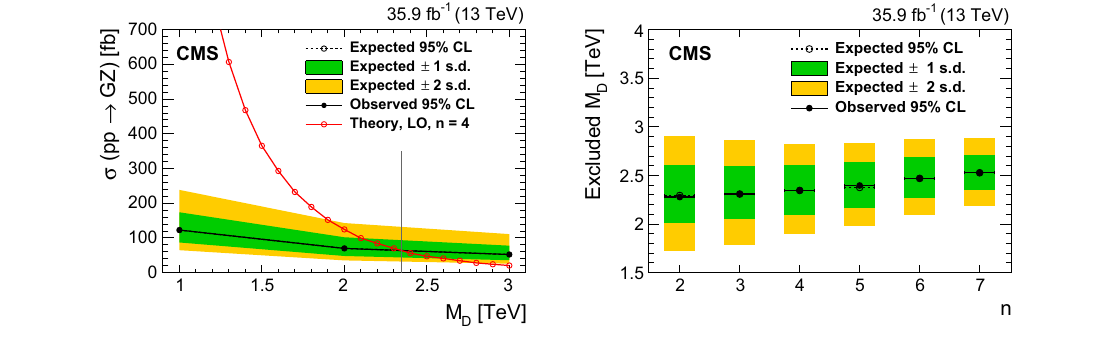
theoretical cross section for the case n = 4. Cross sections are calcu- > 50GeV. The vertical line in lated in the fiducial phase space of p G T the left plot shows the projection onto the M D axis of the intersection of the theory curve with the expected and observed exclusion